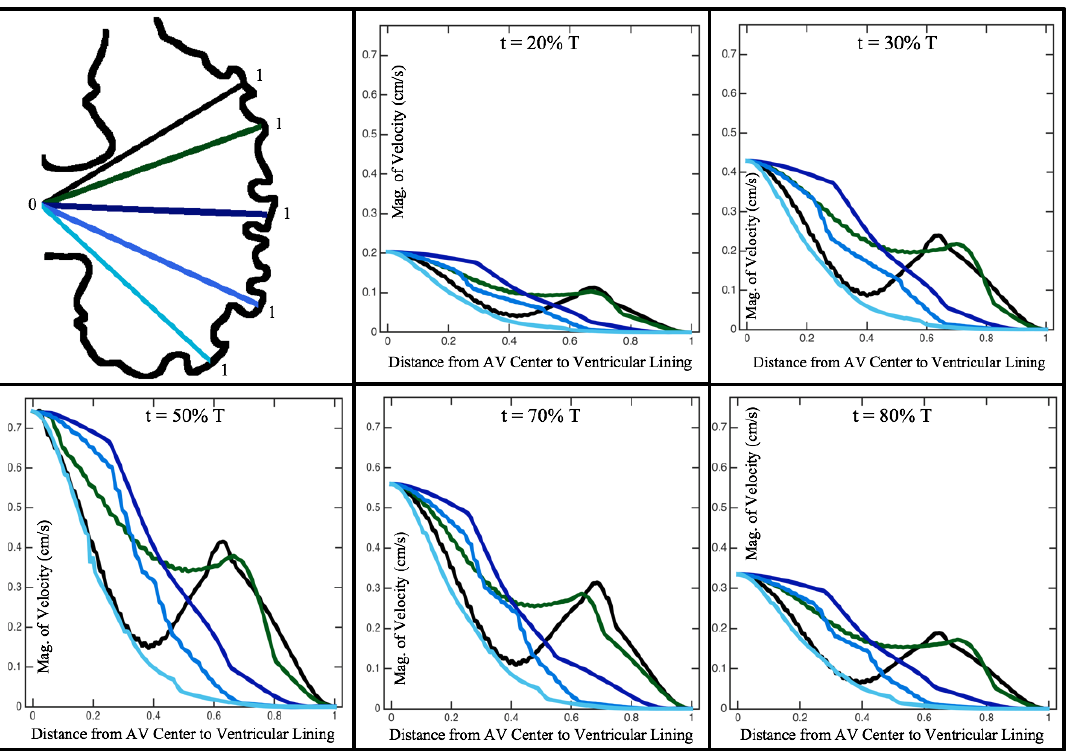
Figure A2. Plots showing how the magnitude of velocity decays from the center of the atrioventricular (AV) canal to the ventricle wall for four different lines across the chamber using a 3 dpf WT embryo’s geometry.